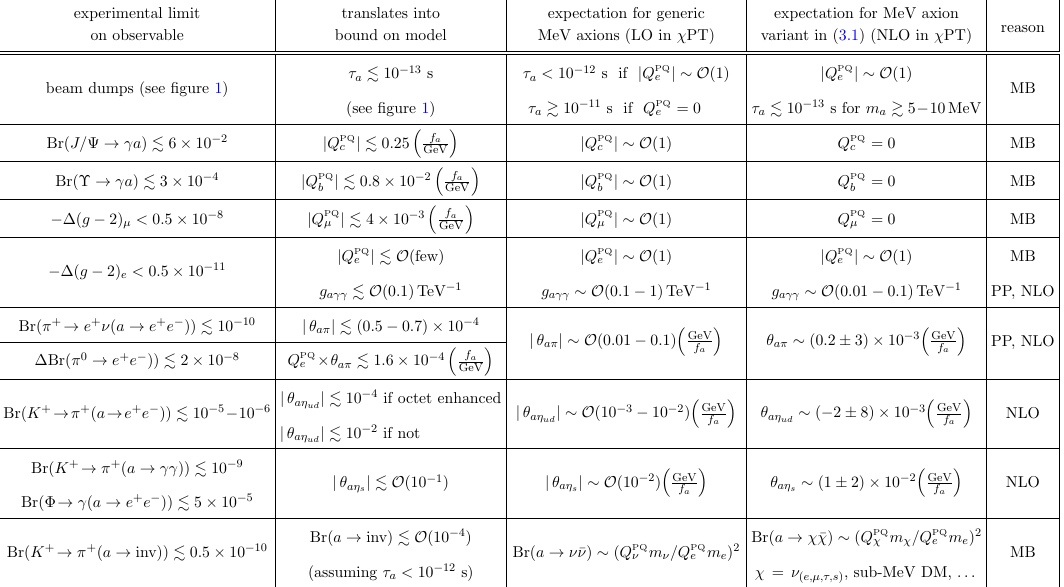
Table 1 . Summary of the most relevant existing bounds on MeV axions, as well as the conditions for experimental viability discussed in this paper. The 3rd column indicates the typical range in generic axion models for the quantity being constrained, estimated at leading order (LO) in chiral perturbation theory ( (cid:31) PT). The 4th column contrasts it with the corresponding expectation for a short-lived, pion-phobic MeV axion which, as we argue in the text, remains compatible with experimental bounds. The 4th column takes into account large uncertainties from next-to-leading order (NLO) in (cid:31) PT. The (cid:12)fth column indicates the reason for the di(cid:11)erence in expected properties of generic models (3rd column) and of the viable variant (4th column), where: MB indicates that the quantity in the 4th column is achievable via model building; NLO indicates that the error in the quantity in the 4th column comes from large corrections at NLO in (cid:31) PT; and PP indicates that the quantity in the 4th column is suppressed due to accidental cancellations at LO in the axion-pion mixing angle (cid:18) a(cid:25) , i.e., pion-phobia